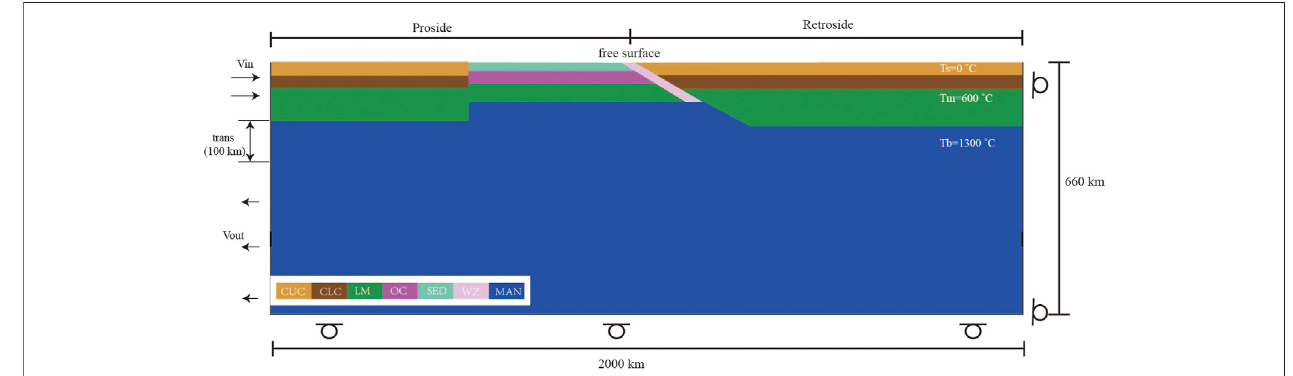
FIGURE2| Con fi gurationofthereferencemodel. Thesizeofthenumericalboxis2000×660 km,andanoceanicplateisintegratedwithacontinentalplateonthe proside (left). The retroside (right) is an overriding continental plate. Various colors re fl ect to different lithologies, CUC: continental upper crust, CLC: continental lower crust, LM: lithospheric mantle, OC: oceanic crust, SED: sediment, WZ: weak zone, and MAN: sub-lithospheric mantle. Ts is surface temperature, Tmn is the Moho temperature of normal continent, Tmc stands for the Moho temperature of continental Craton, Tb is the bottom temperature of lithosphere. V in and V out denote where material fl ow in and out, and V trans denotes the transition zone from fl ow in to fl ow out.